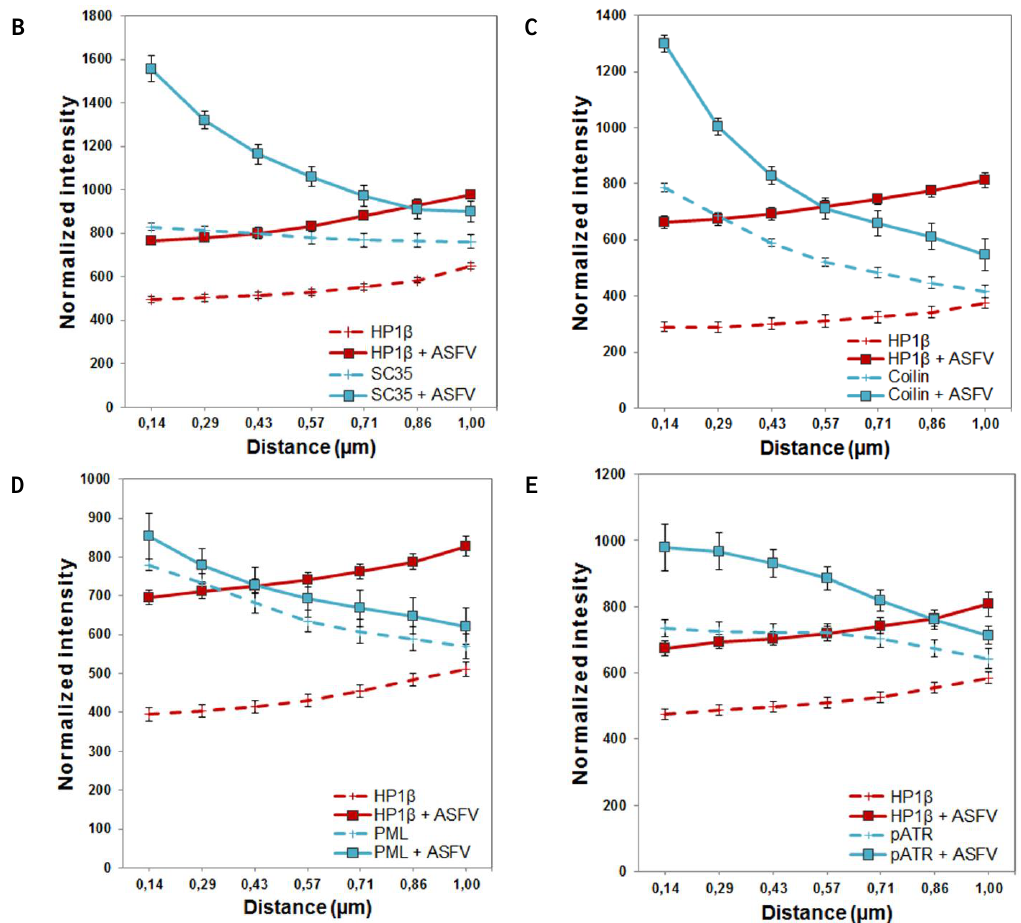
Figure 5. ASFV leads to juxtaposition of host heterochromatic regions, disrupted subnuclear domains and pATR foci. ( A ) Heterochromatin marker HP1 β is labelled in red, while subnuclear domains (PML-NBs, nuclear speckles or Cajal bodies) and the activated ATR kinase are labelled in cyan. Cell nuclei were counterstained with DAPI (blue). ( a – d ) Only ASFV-infected cells (green) display the speckled pattern of enlarged SC-35 accumulations (cyan) juxtaposed to the heterochromatic regions (HP1 β , red), as non-infected cells do not reveal the close proximity pattern ( a’ – d’ ). In contrast to non-infected cells ( e’ – h’ ), the ASFV-induced bulky heterochromatic territories (HP1 β , red) are always present within close vicinity to disrupted Cajal bodies (cyan) ( e – h ). Enlarged heterochromatic regions (HP1 β , red) closely neighbour reorganized PML-NBs (cyan) in infected cells (green) ( i – l) , rearrangements not observable in non-infected cells ( i' – l’ ). HP1 β deposits (red) juxtapose to pATR foci (cyan), in ASFV-infected cells (green) ( m – p ), different chromatin/pATR appearances and distributions in non-infected cells (m’–p’). Scale bar, 10 µ m. Representative microscopy images of at least three independent experiments are shown; ( B – E ) Relative distance between the studied subnuclear domains/pATR foci (cyan) and heterochromatic regions (red) was evaluated by radial intensity profile analysis in ASFV-infected cells (solid lines) and non-infected cells (dashed lines). Normalized fluorescence curves were obtained from 50 nuclei. Experiments were performed in triplicate and error bars represent standard errors ( ˘ SE). Radial profile analysis shows the close proximity, in ASFV-infected cells, between each subnuclear domain/pATR foci (blue solid line) and HP1 β accumulations (red solid line), crossing at a point within the given radius (1 µ m). Dashed lines representing fluorescence intensities of subnuclear domains/pATR (blue) and heterochromatic regions (red) never intersect, revealing a greater distance between these nuclear domains/factors in non-infected cells.